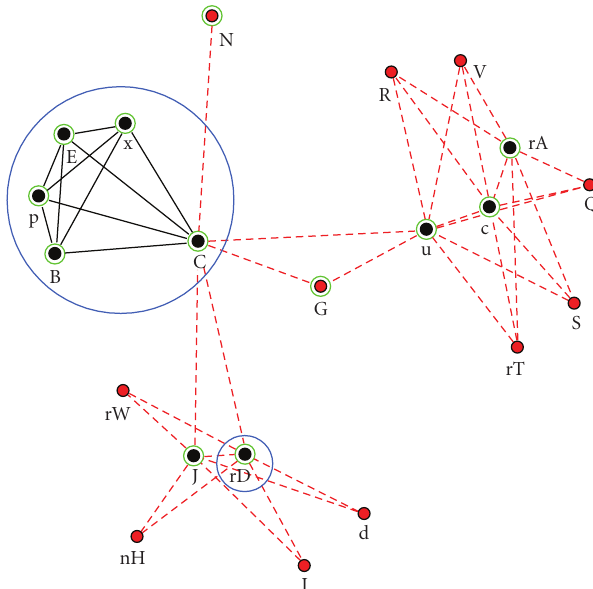
Figure 14: KeyGraph of cluster 1, where rD (attacks the boss monster residing in the most remote map from the initial map) is one of the